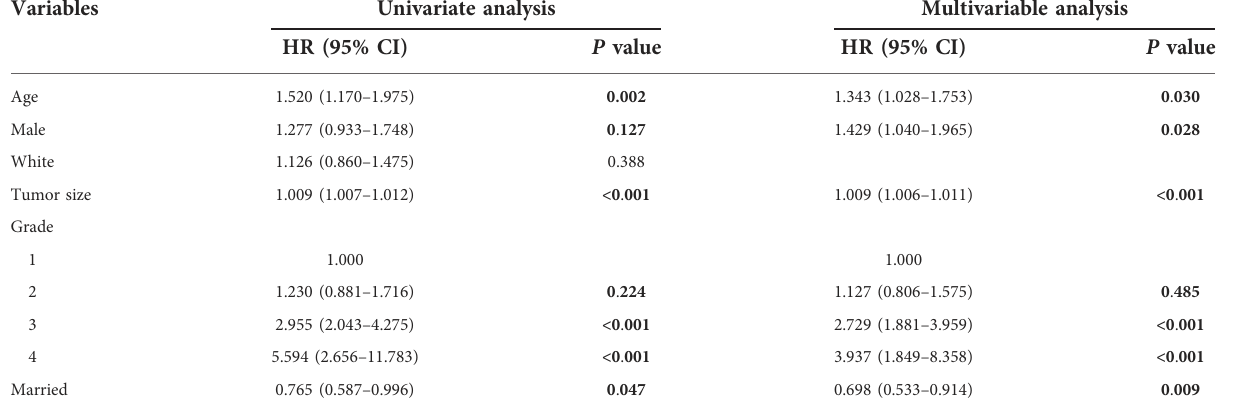
TABLE 2 Univariate and multivariable analyses of SEER database cohort.